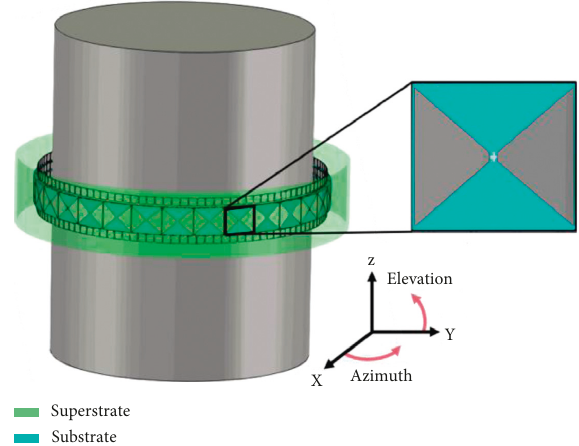
Figure 1: Tightly coupled array under analysis: 3-D